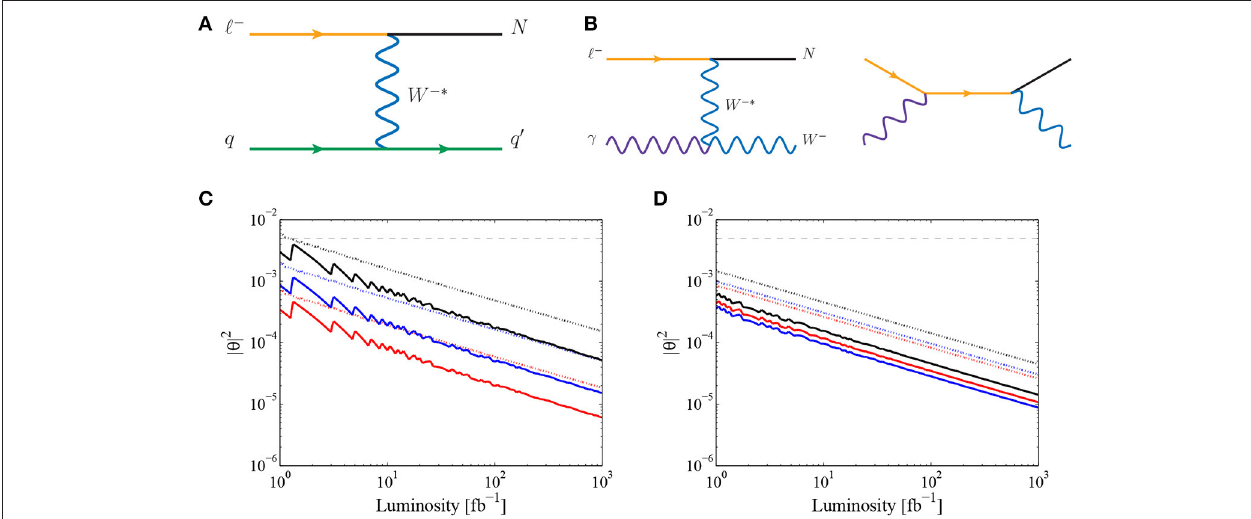
2 (or 2 ) sensitivity vs. V ℓ N θ | | | | 2 TeV; red (blue) [black] line in (C,D) =